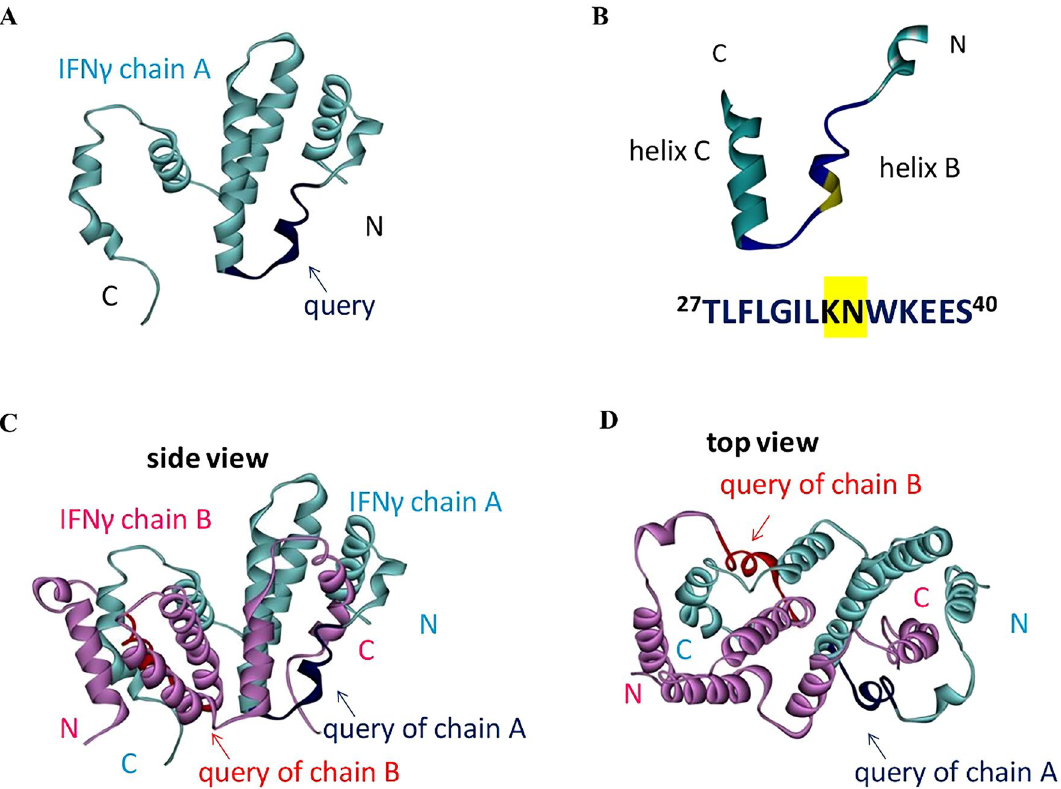
Figure 1. The query portion on human IFN-γ structure, PDB ID: 1FG9. ( A ) Single IFN-γ molecule, ( B ) the gap position on IFN-γ (yellow-highlight), ( C ) side view of homo-dimer IFN-γ, and ( D ) top view of homo-dimer IFN-γ. Blue and red colors represent the query aligned on IFN-γ chain A and chain B,